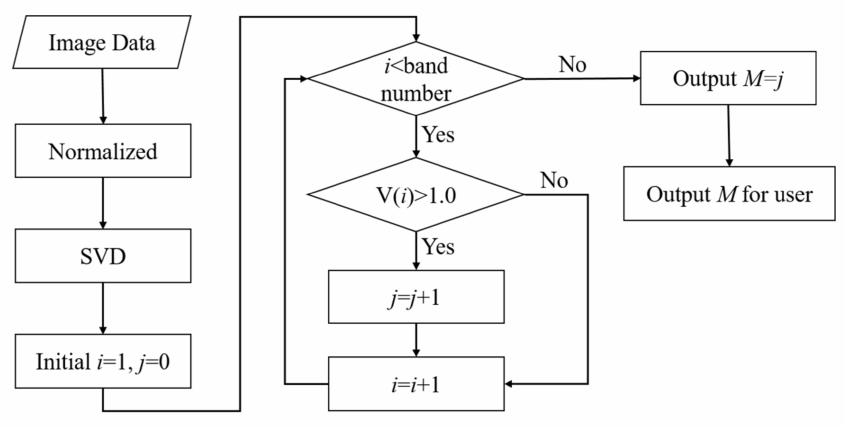
Figure 3. Obtaining the initial value of M with the SPEEVD